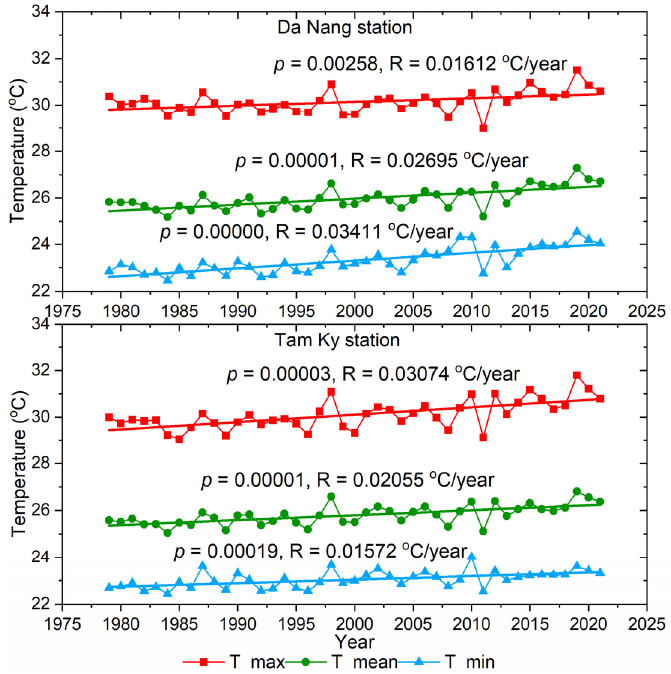
Figure 6. The distribution of built-up area in ( a ) 2000, ( b ) 2005, ( c ) 2010, and ( d ) 2020 in Quang Nam province.